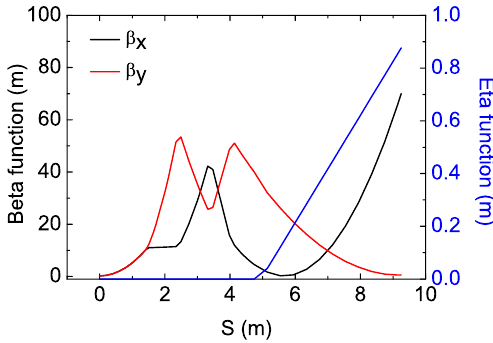
FIG. 3. Energy gain along APS linac. Black and red colors indicate PCG and RG2 beam,